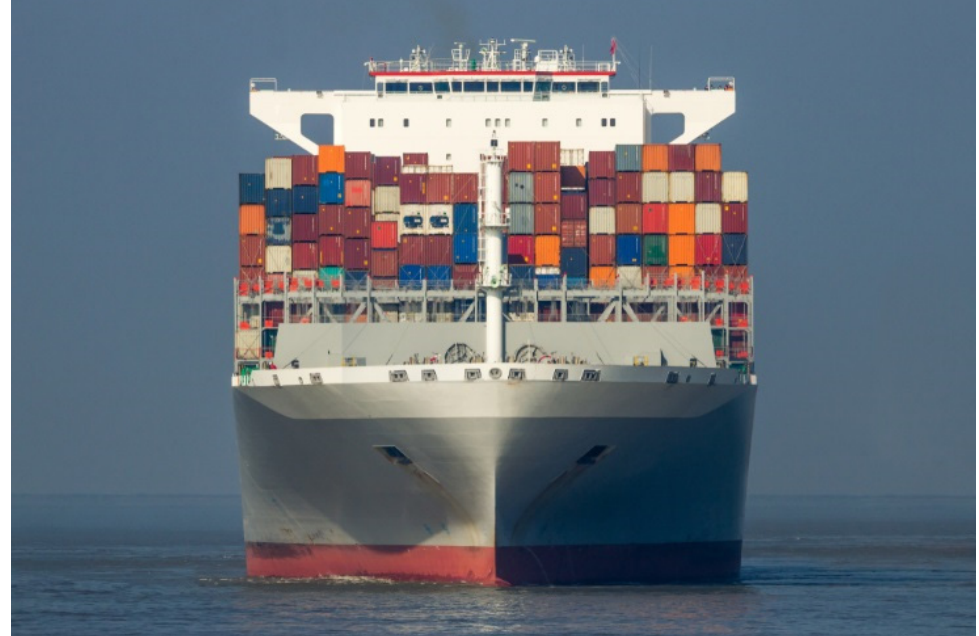
Figure 37. The profile of a large container ship from a forward view. While the angled hull presents a lower drag coefficient, most of the above-deck structure and load offer high resistance.